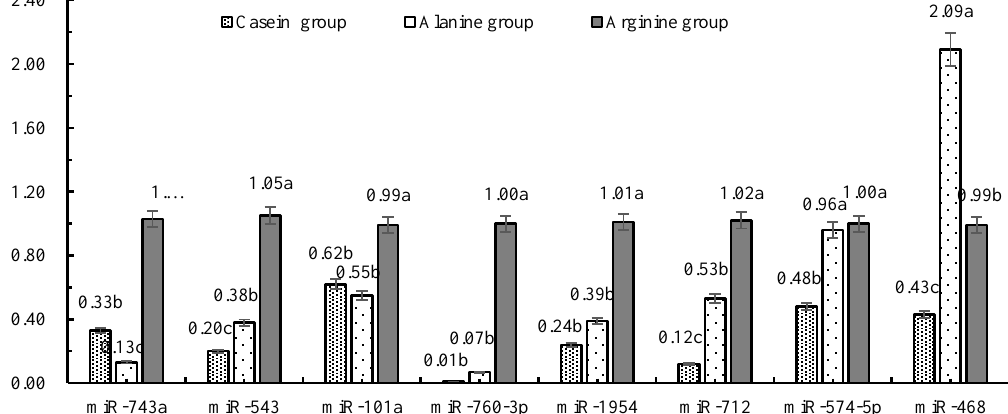
Figure 2. Expression of target miRNA in mammary tissue from lactating Holstein cows in response to jugular infusions. Values with different lower case letters differed ( P < 0.05).